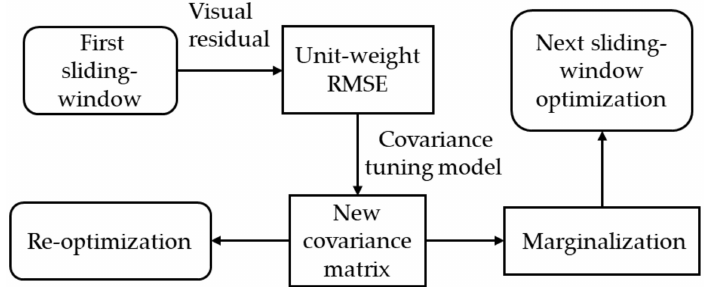
Figure 5. Role of the covariance matrix.